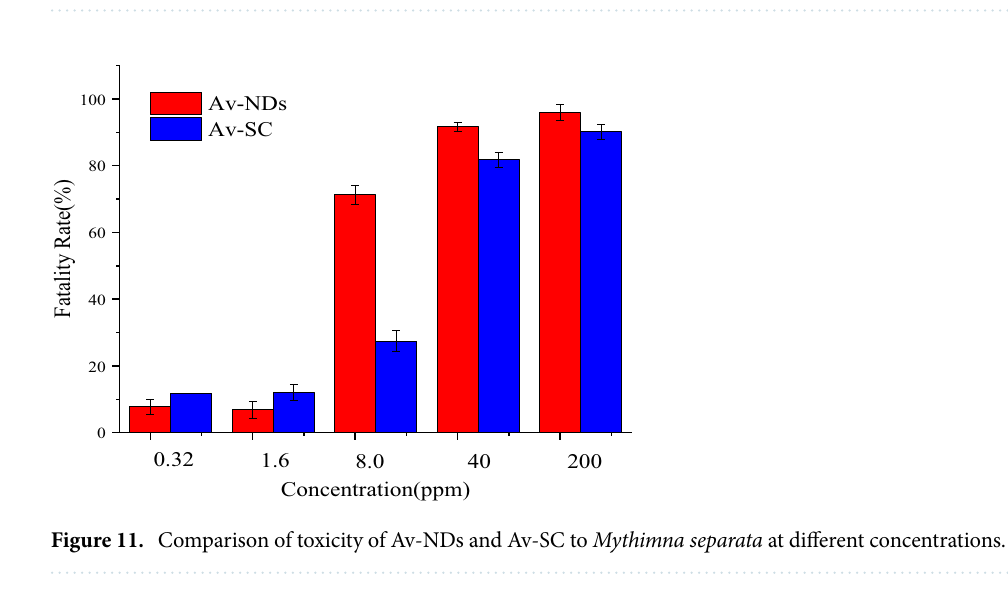
Figure 10. Comparison of the UV-Shielding Properties of Av-NDs with tech. Av.